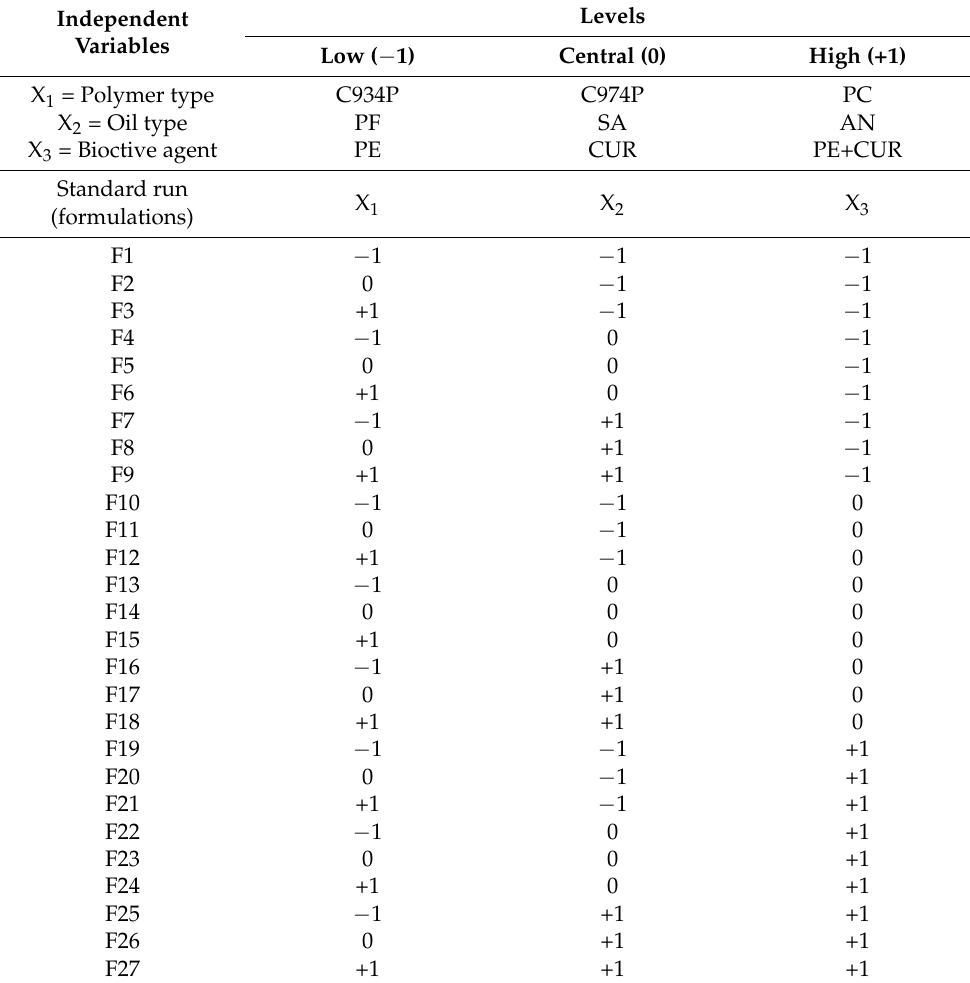
Table 3. Matrix of factorial design 3 3 for the emulgel systems containing three types of polymers (C934P, C974P, PC), vegetable oils (PF, SA, AN) and also three combinations of bioactive agents (PE, CUR,